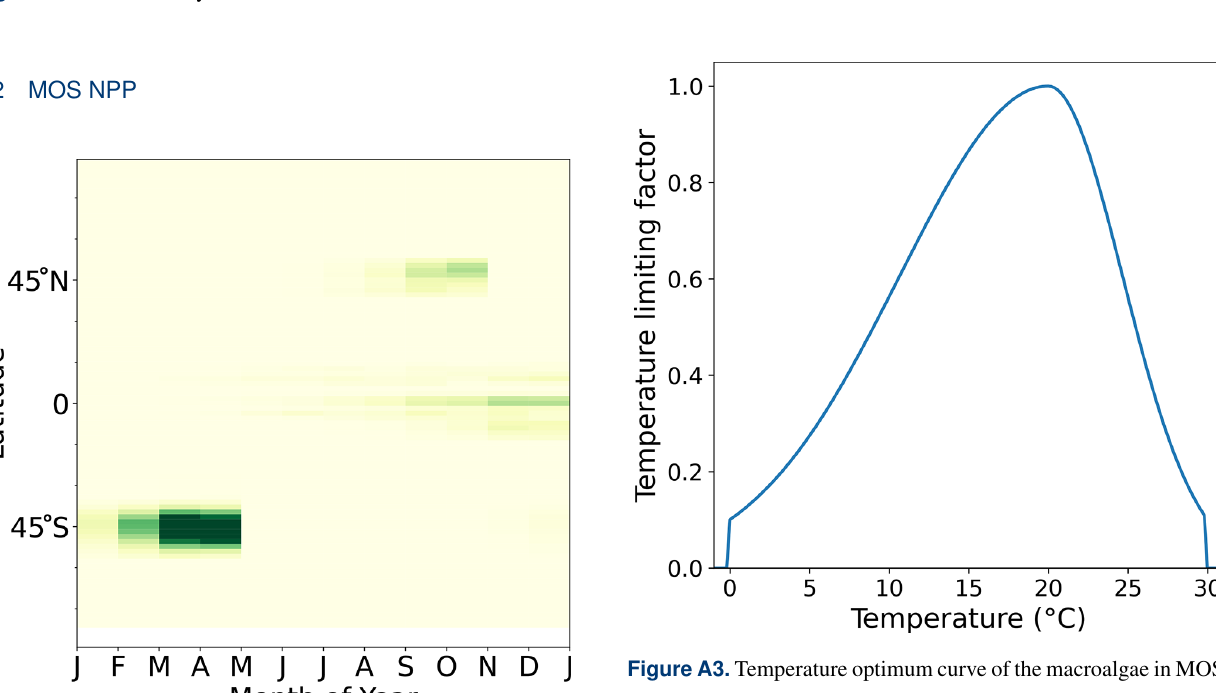
Figure A1. Sketch of key features of MOS.